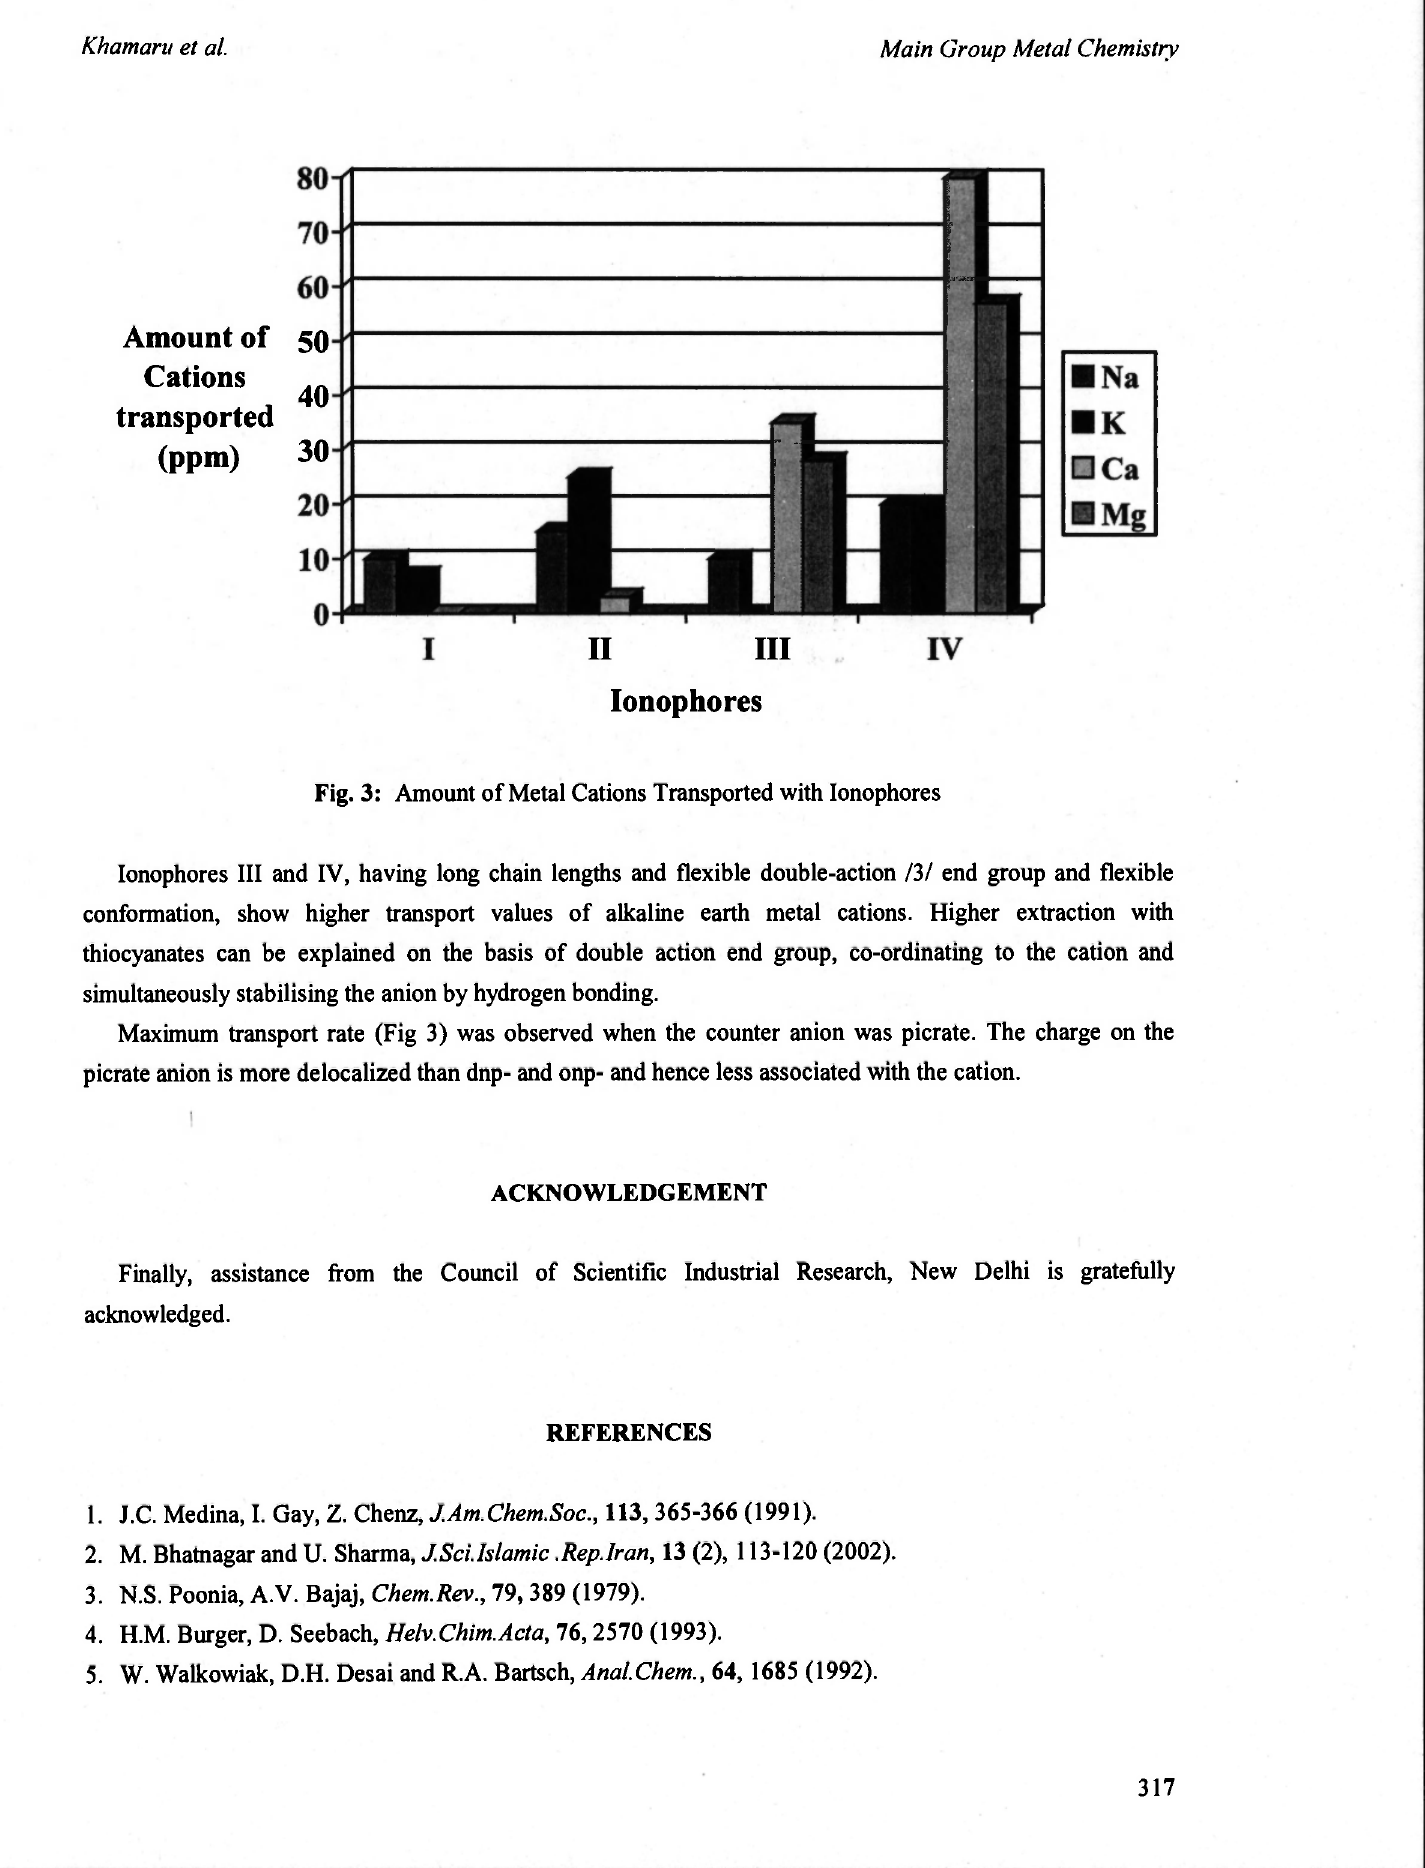
Fig. 3: Amount of Metal Cations Transported with